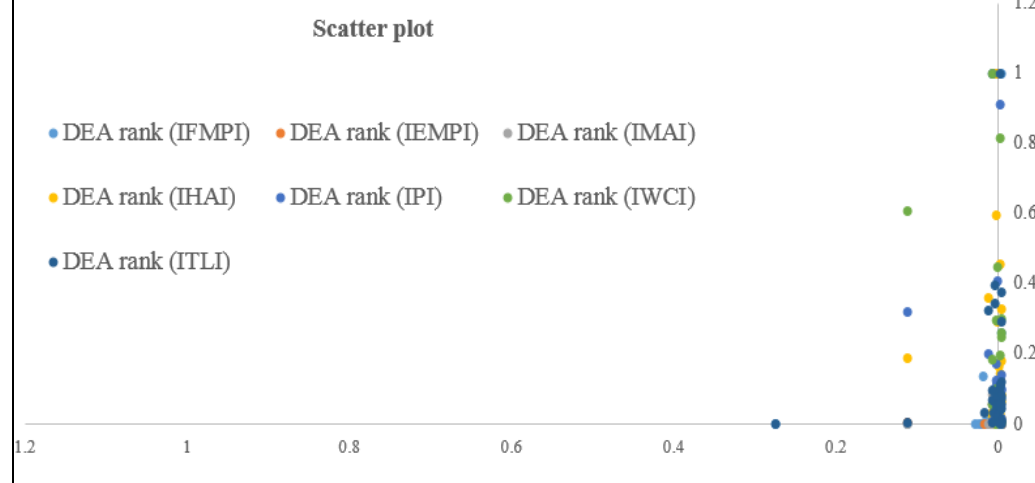
Figure 6: The scatter plot of DEA ranks of industrial